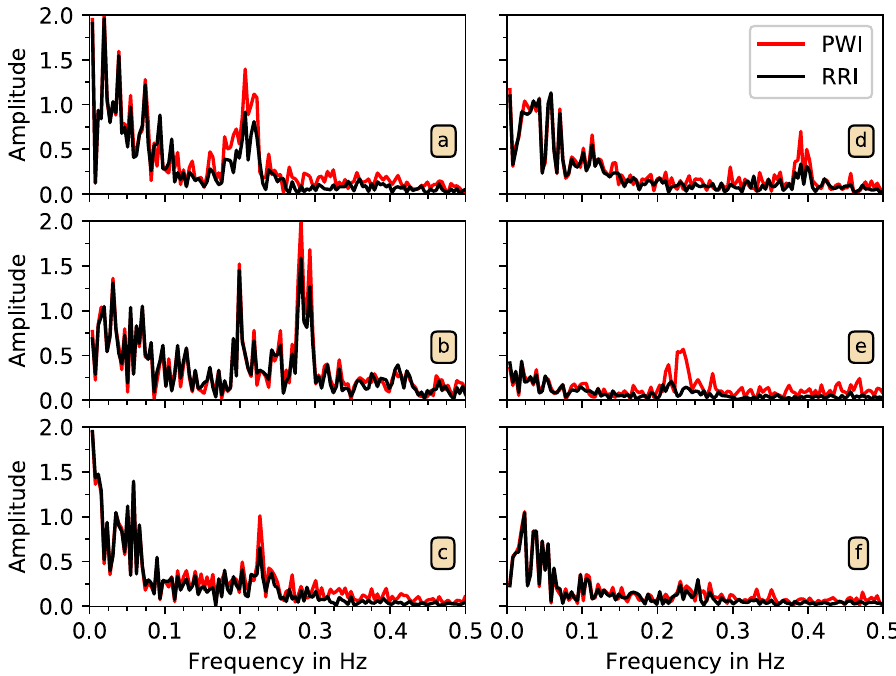
Fig 11. Spectral analysis of PWI and RRI time series. The spectra of PWI data (red) and RRI data (black) are shown for six subjects. In all cases except for (f), the peak in the (respiratory) HF band (0.15 to 0.4 Hz) is increased in the PWI-based